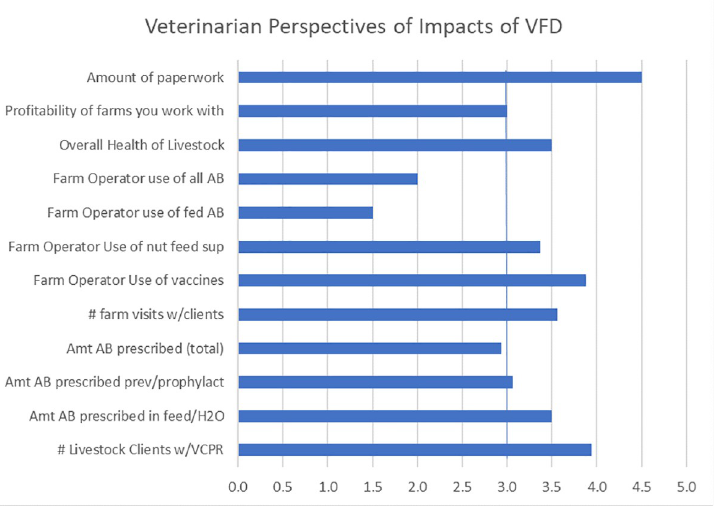
Fig 4. Mean scores for veterinarian responses describing the impact of VFD. Likert scale responses (n = 8) in which 1 = Decrease a lot, 2 = Decrease a little, 3 = No Change, 4 = Increase a little, 5 = Increase a lot. Vertical line represents the response of “No